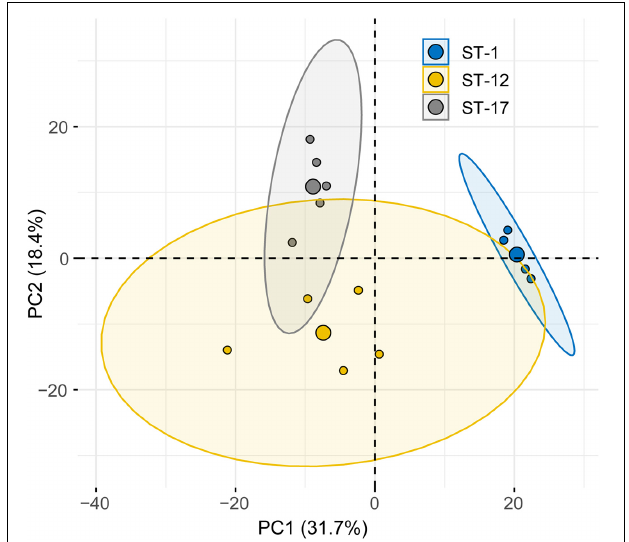
FIGURE 6 | Principal component analysis (PCA) reveals lineage-specific clustering of membrane vesicle (MV) proteomes. PCA of the MV proteomes produced by six strains stratified by sequence type (ST). The large central dot of each ellipse represents the mean point of the corresponding 95% confidence ellipse, while the smaller points represent individual proteomic samples. Confidence ellipses comprise 95% of the samples based on the underlying distribution. Axes percentages represent the amount of variation accounted for by each principal component (PC).